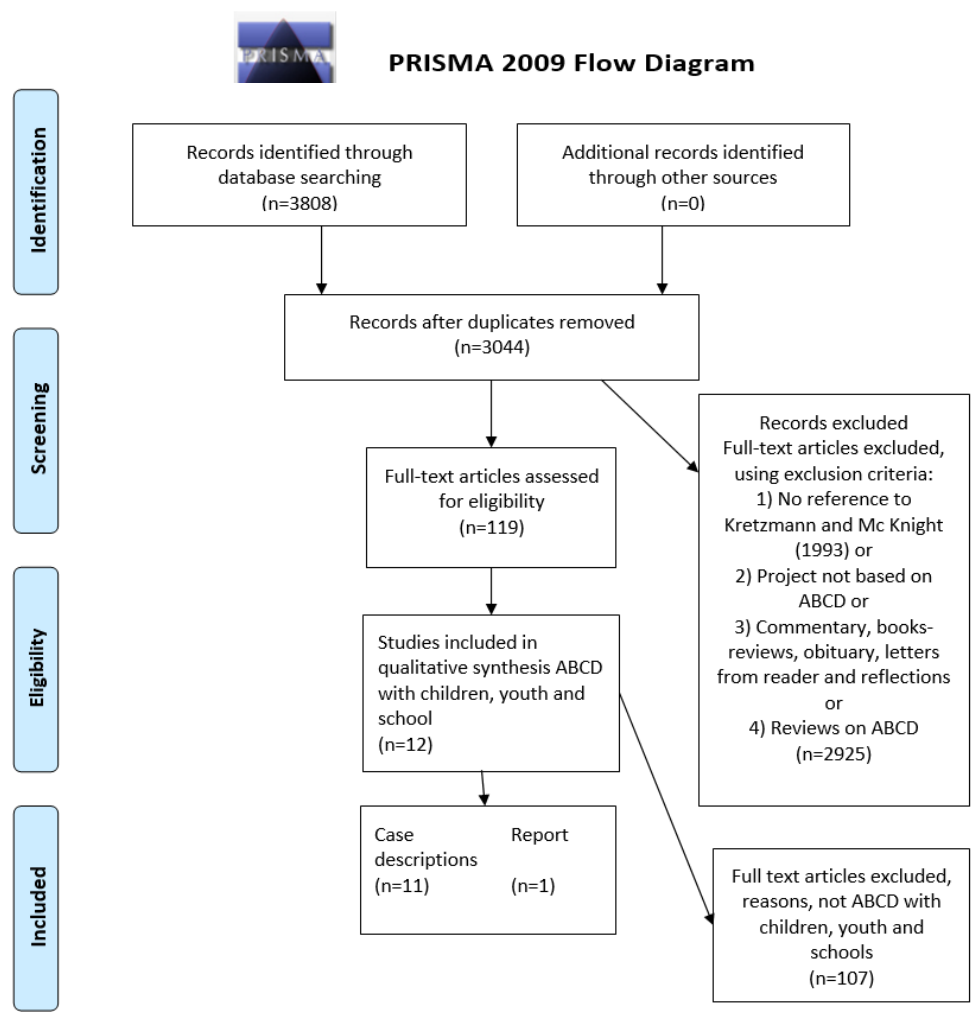
Figure 1. PRISMA flow diagram. ABCD, asset-based community development.